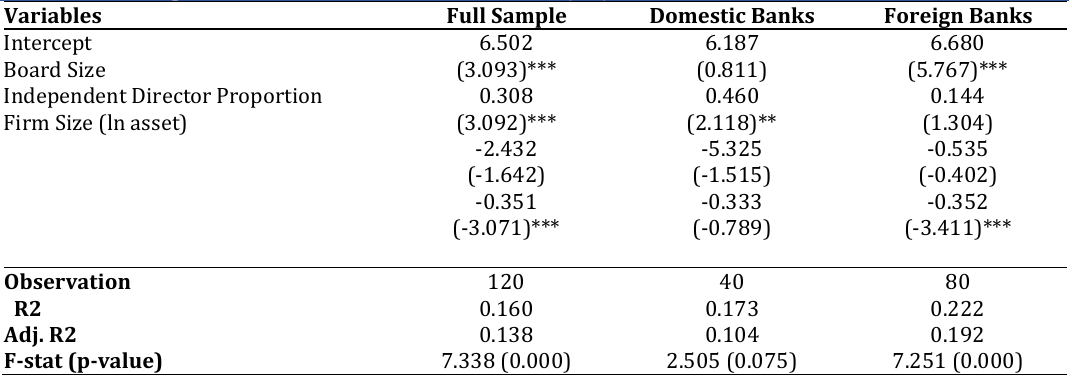
Table 7: The Regression Models for Current Ratio